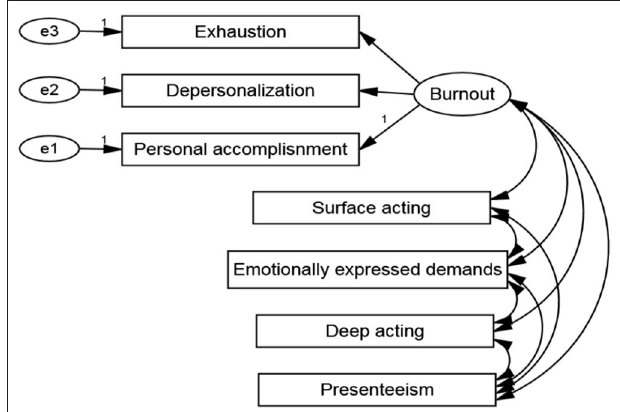
FIGURE 2 | The measurement model.